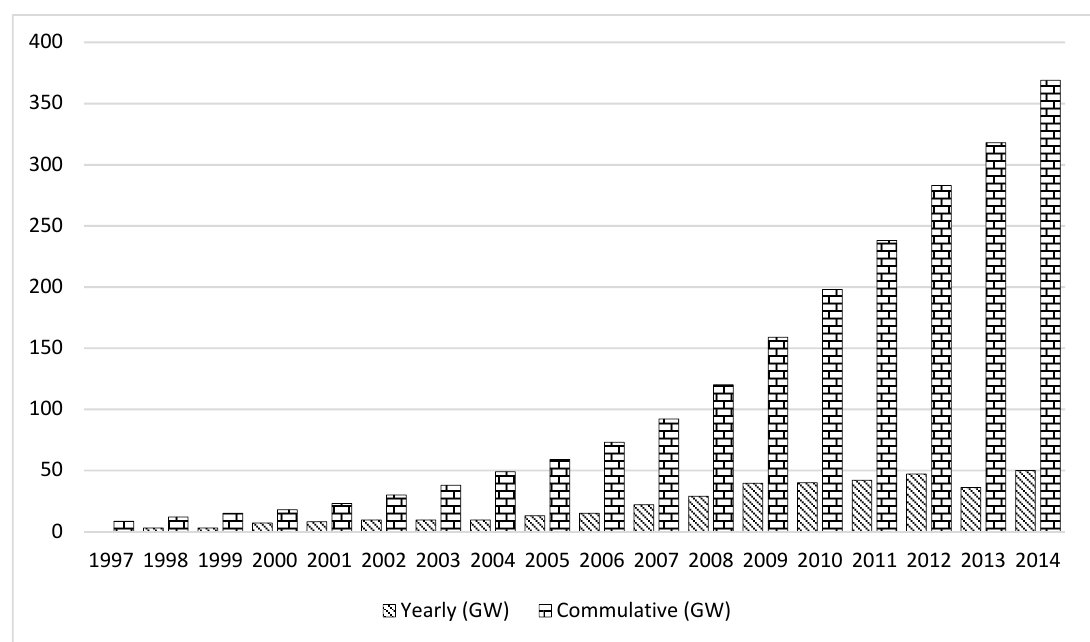
Figure 13. Overall installed wind energy capacity from 1997 to 2014.